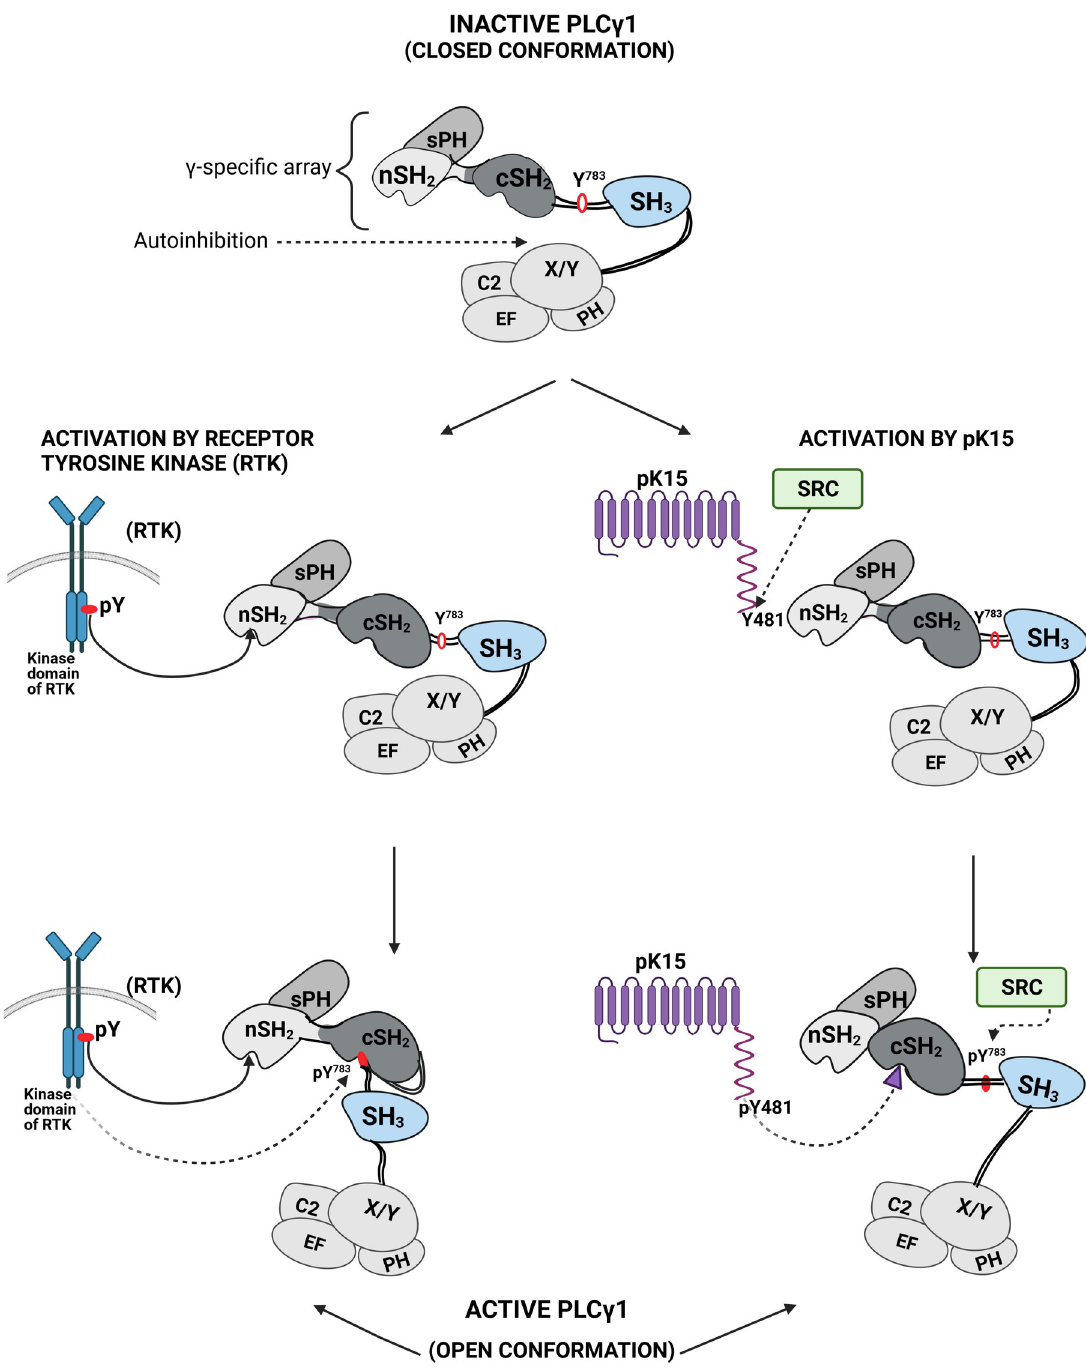
Fig 8. Diagram illustrating the activation of PLC γ 1 by receptor tyrosine kinases or pK15. Top: Model of PLC γ 1 showing individual PLC γ 1 domains. nSH2, cSH2: N-terminal and C-terminal SH2 domain; SH3: SH3 domain; sPH: split PH domain; C2: C2 domain; EF: EF domain; X/Y: catalytic core domain. PLC γ 1 is depicted in its closed, enzymatically inactive conformation, in which the cSH2 domain is positioned in the proximity of the catalytic core (X/Y). The model is based on findings reported in references [43,44,45,46,66]. Below Left: Activation of PLC γ 1 by receptor tyrosine kinases (RTK): following autophosphorylation on tyrosine residues, the cytoplasmic RTK domain recruits the PLC γ 1 nSH2 domain and phosphorylates PLC γ 1 Y 783 , which in turn binds into the cSH2 domain, thus removing it from its proximity to the catalytic core, and thereby activates the enzymatic activity of the latter. Below Right: Activation of PLC γ 1 by pK15: as shown in this report, the phosphorylated Y 481 of pK15 (phosphorylated by Src in our experiments) binds into the PLC γ 1 cSH2 domain. This presumably leads to a conformational change in PLC γ 1, which in turn facilitates the subsequent phosphorylation of PLC γ 1 Y 783 by members of the Src kinase family and subsequent activation of PLC γ 1 lipase activity. https://doi.org/10.1371/journal.ppat.1009635.g008 PLOS Pathogens| https://doi.org/10.1371/journal.ppat.1009635 June 18,